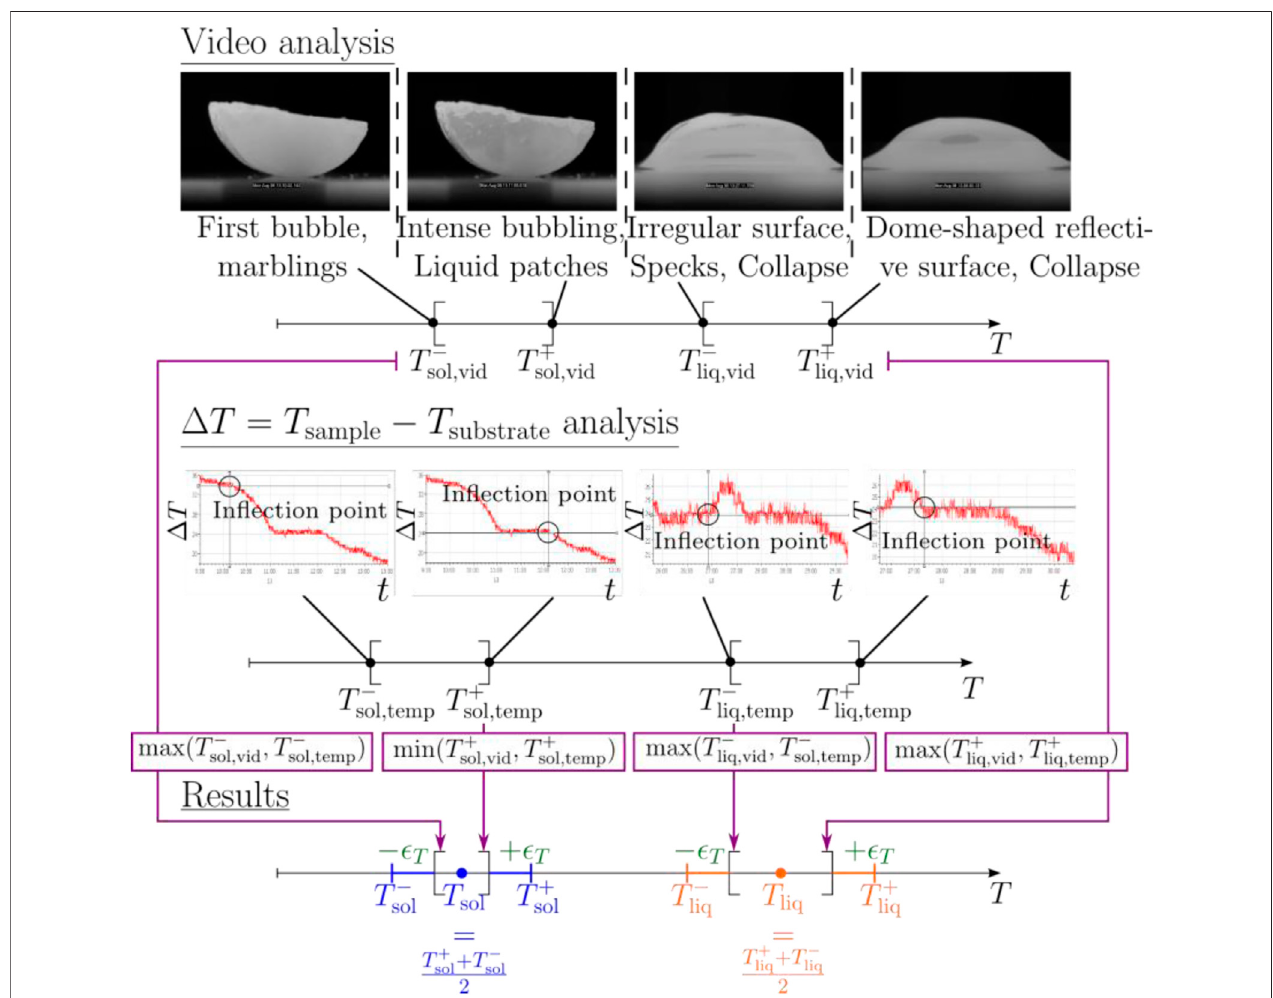
FIGURE 10 | Principle of visual polythermal